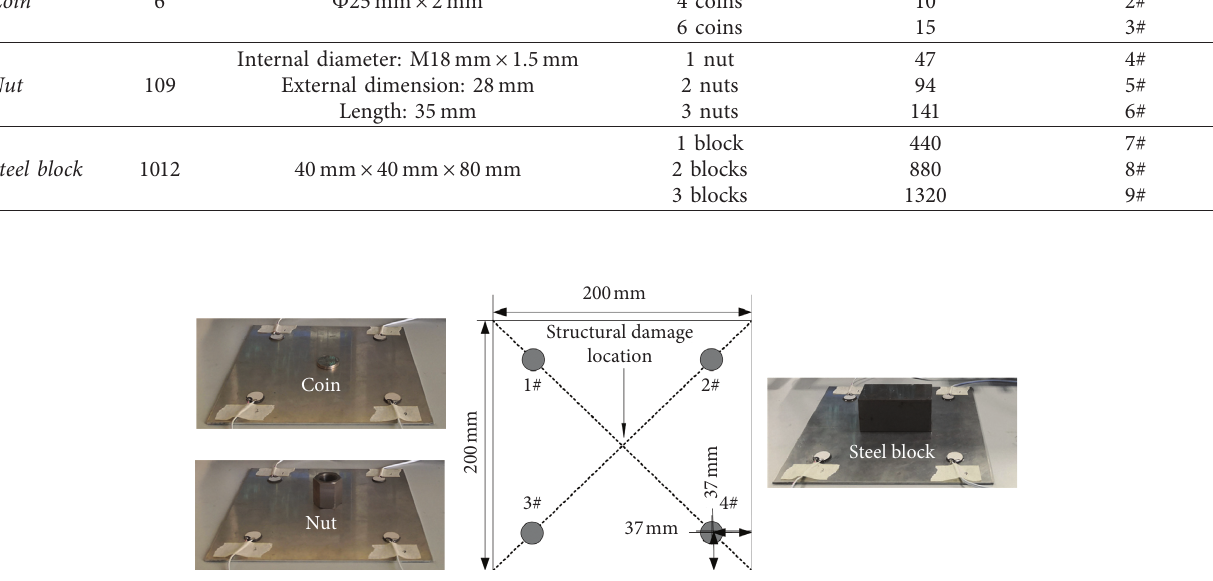
Figure 3: Settings of structural